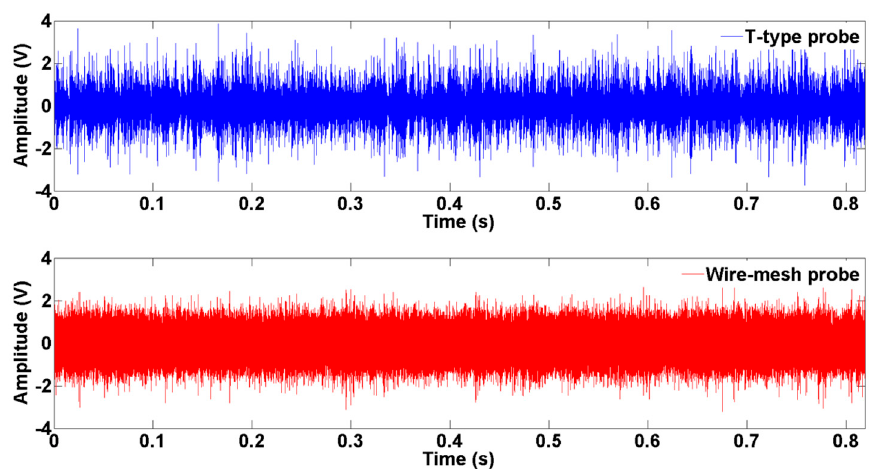
Figure 5. Raw acoustic emission (AE) signals obtained by the T-type probe and wire-mesh probe.